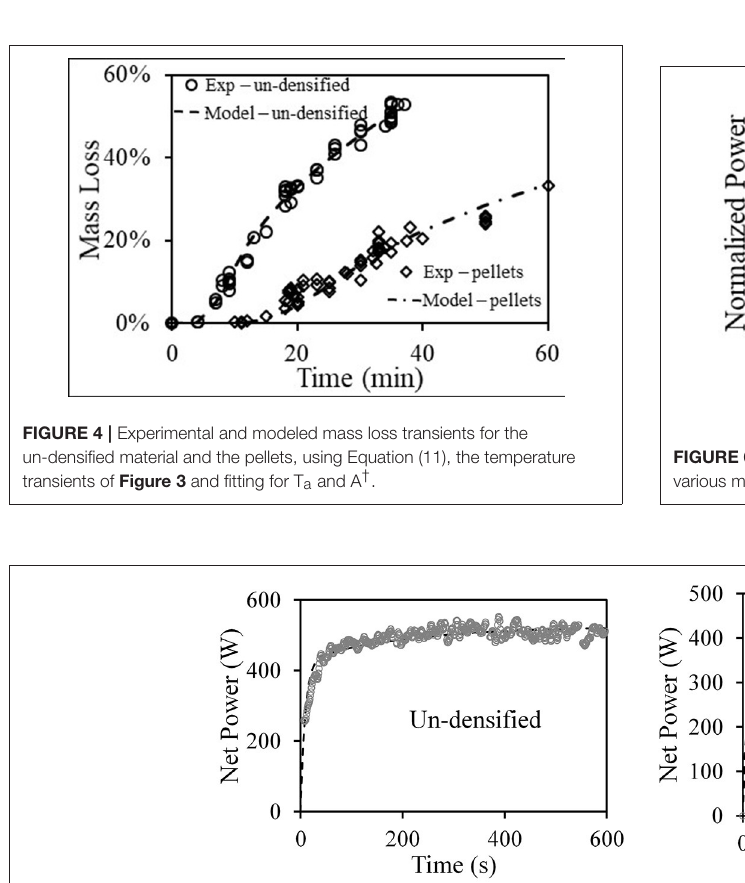
FIGURE 3 | Temperature transient for the un-densified material and the pellets, using Equation (7) and characteristic times of 160 (s) for the former and 475 (s) for the later.